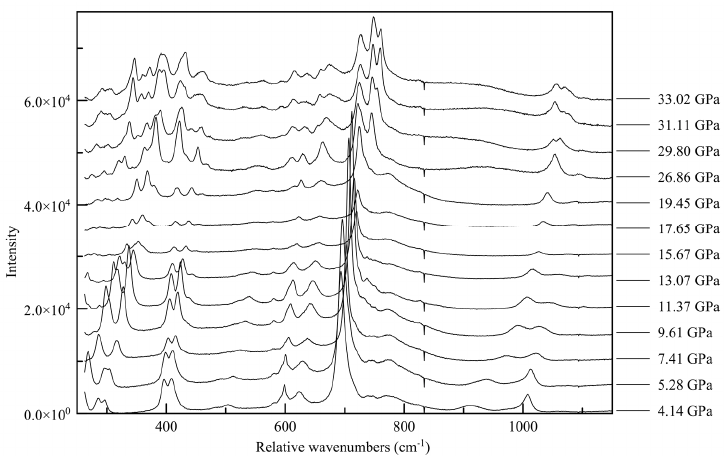
Figure 14. Raman spectra of melamine in the ring vibration-mode range, vertical offset indicates pressure steps in GPa. Splitting of the 750 cm − 1 and 1100 cm − 1 peaks is observed at 29.80(5) GPa in